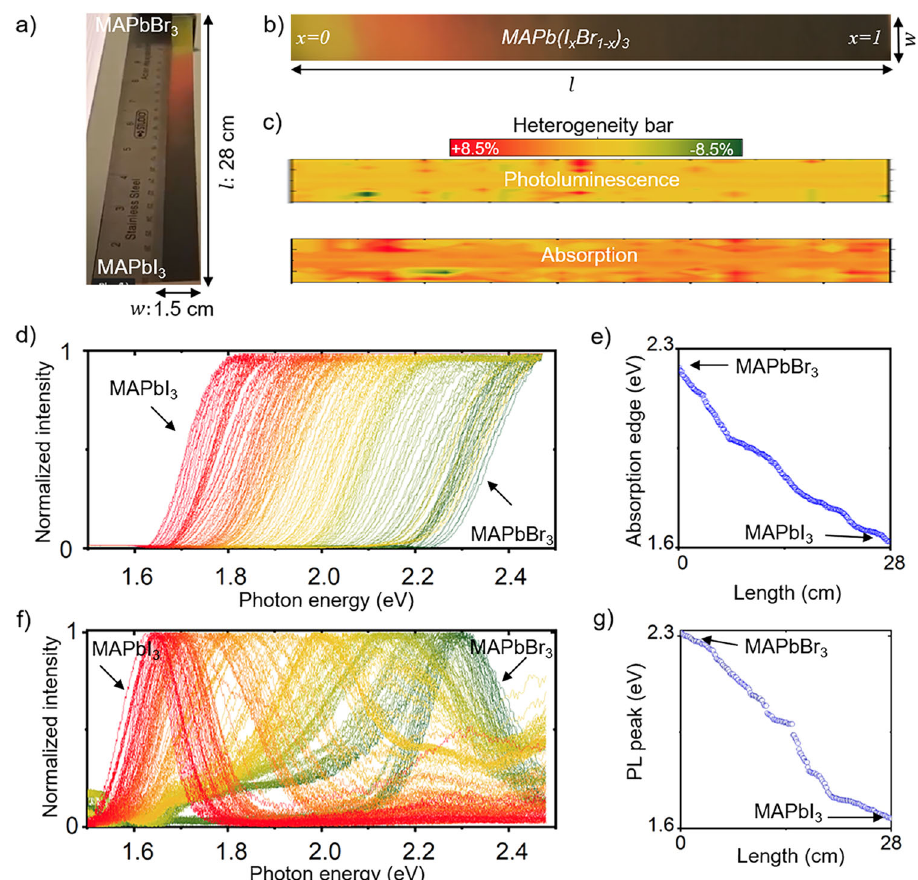
Fig. 2 Characterization of CGFs. a Side-view and b top-view of CGF. c Quanti fi cation of heterogeneity across the width of the CGF by normalizing absorption and photoluminescence bandgaps to the center of the CGF. d Normalized absorption Tauc plots of fresh CGF and e extracted absorption bandgaps for 215 locations. f Normalized photoluminescence spectra of fresh CGF and g extracted PL bandgaps for 215